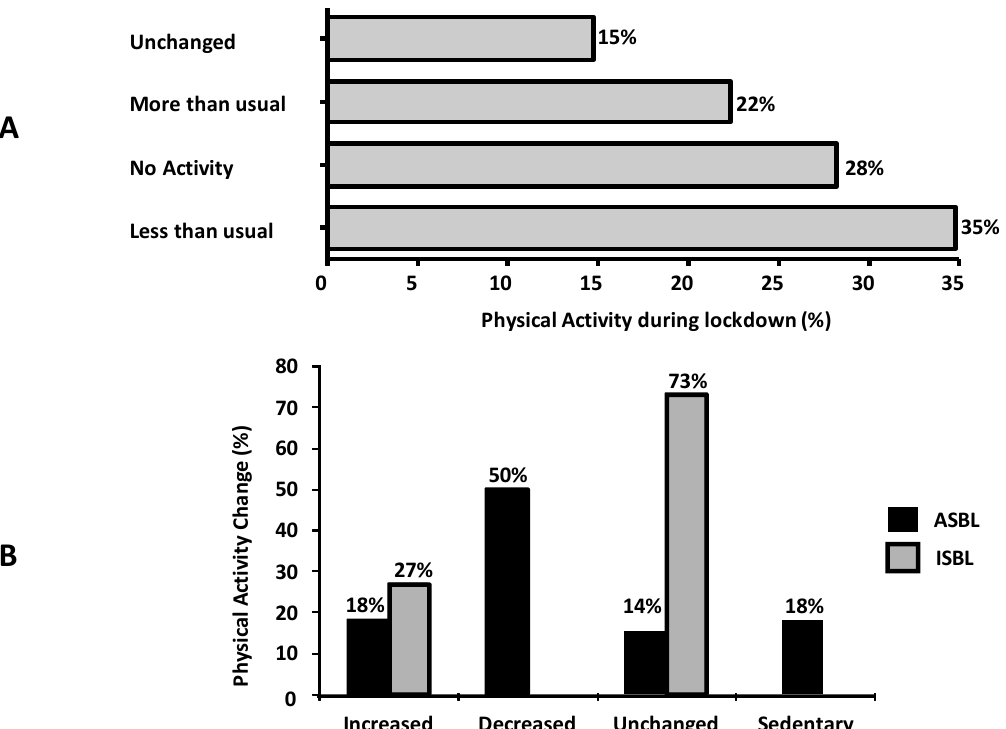
Figure 2. Frequencies of the reported changes in physical activity ( A ); physical activity changes in subjects who were active before lockdown (Active Subjects Before Lockdown (ASBL), black columns) and in subjects who were inactive before lockdown (Inactive Subjects Before Lockdown (ISB), grey columns) ( B ).